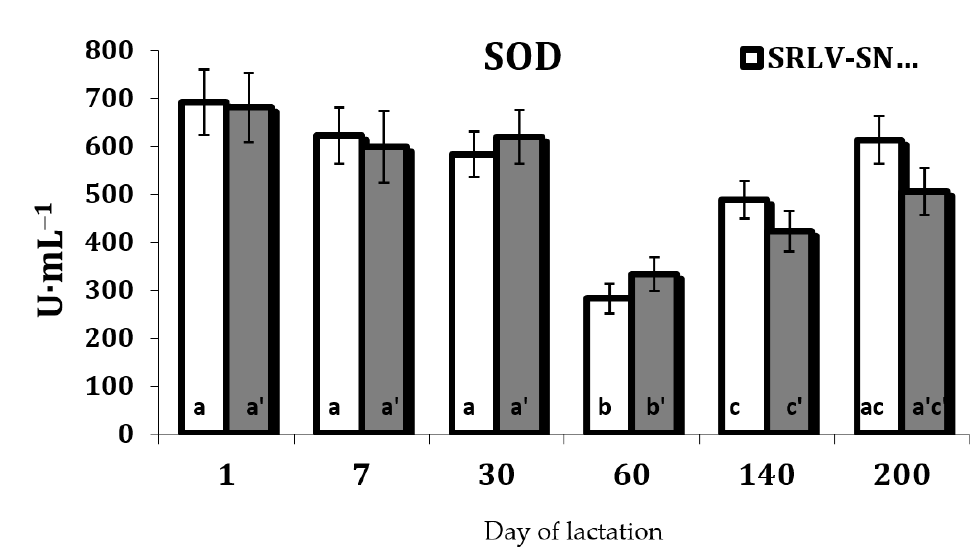
Figure 6. Superoxide dismutase activity (SOD, U · mL − 1 ) in the serum of SRLV-SN and SRLV-SP goats during lactation. Values are expressed as means ± SEM; a, b, c—different letters indicate significant differences between stages of lactation within the SRLV-SN group at p < 0.05; a’, b’, c’—different letters indicate significant differences between stages of lactation within the SRLV-SP group at p < 0.05; SRLV-SP—small ruminant lentivirus seropositive goats; SRLV-SN—small ruminant lentivirus seronegative goats.